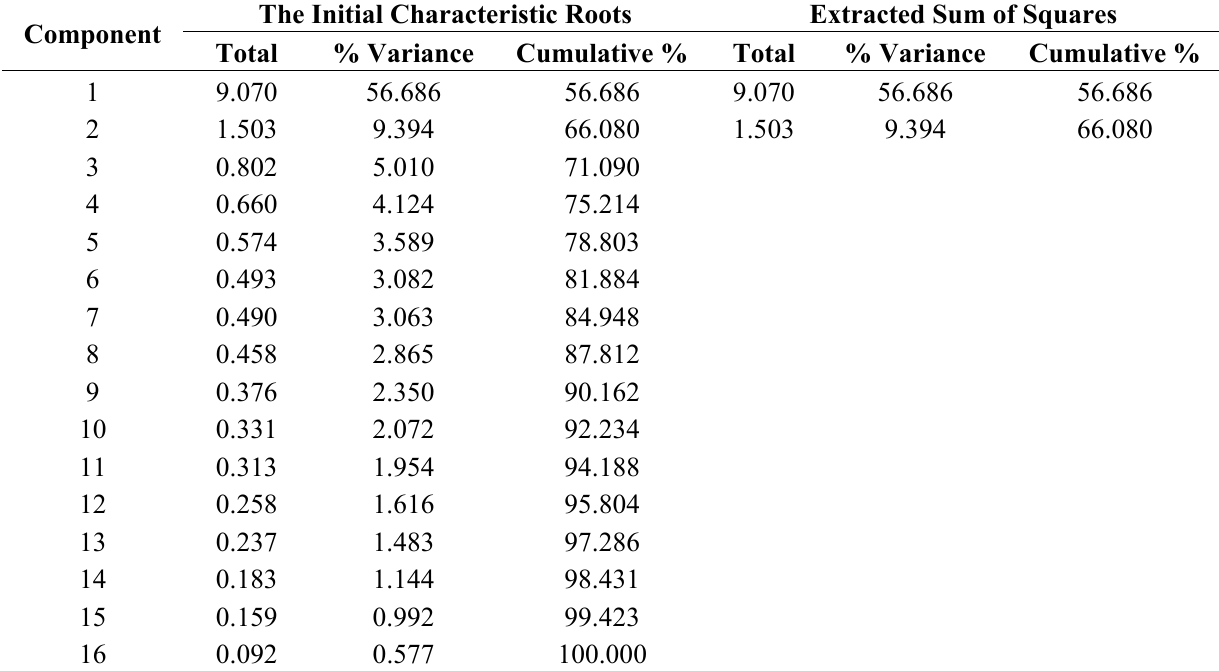
Table 3. Total variance explained after the principle components analysis of the 16 items.